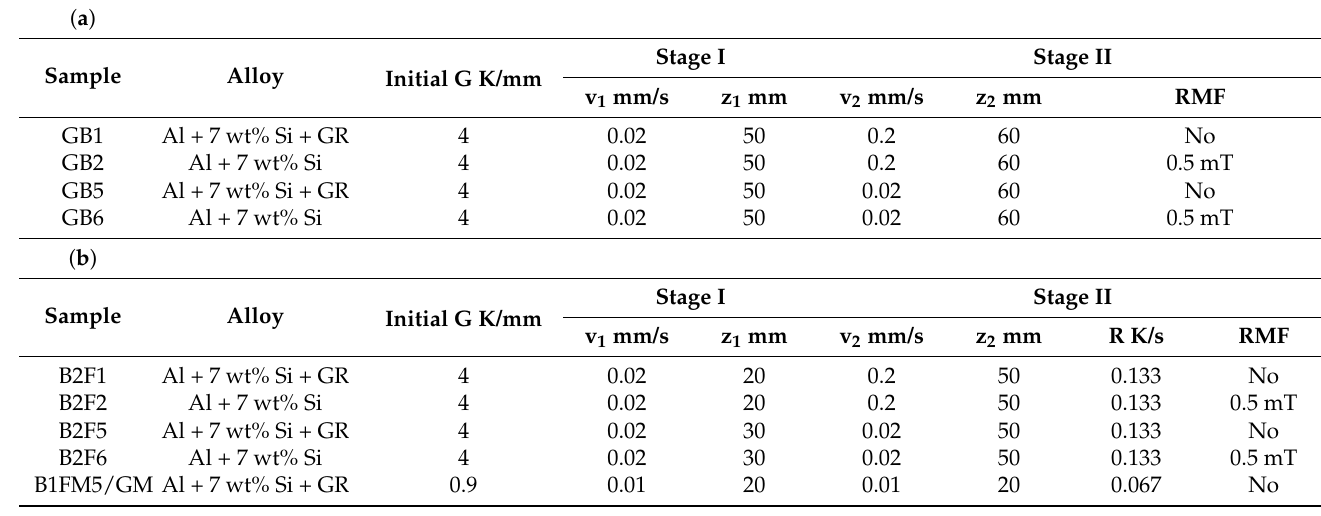
Table 1. (a). Parameters of GB experiments. (b) Parameters of B2F, FM space, and GM ground